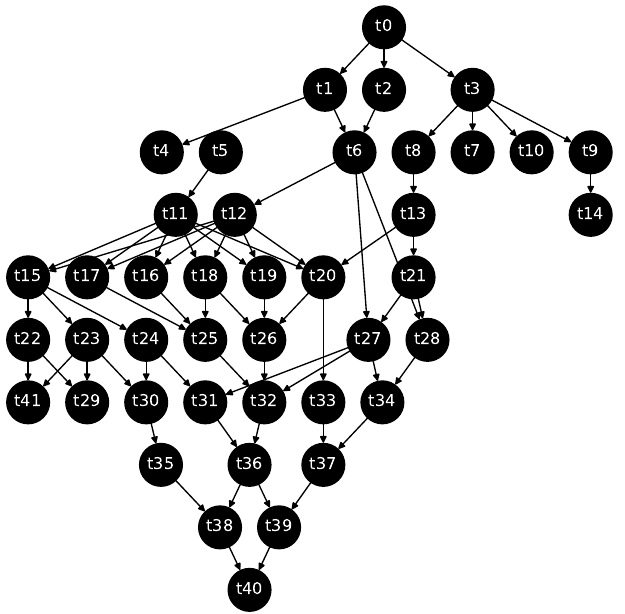
Figure 4. Task dependencies (Workflow